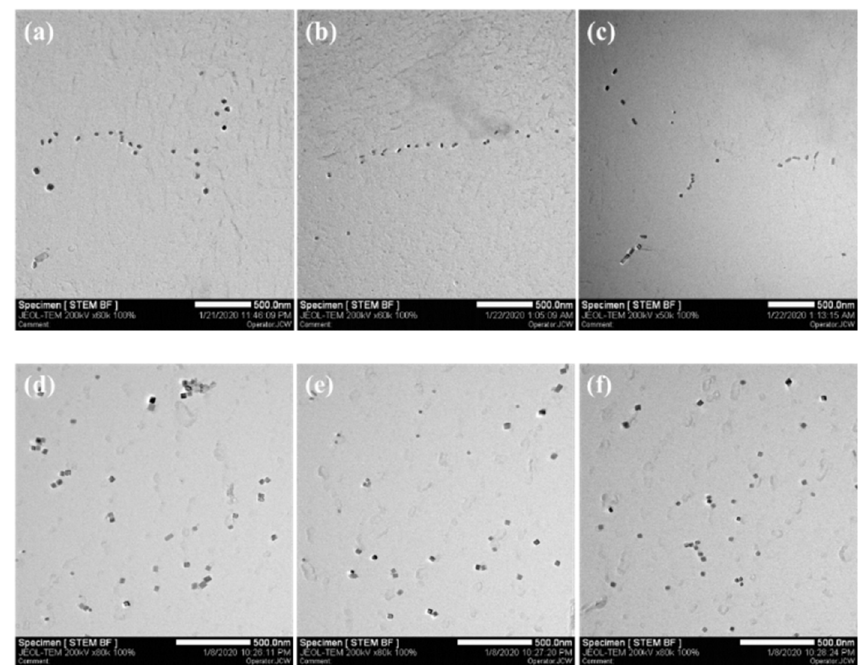
Figure 14. Appearance of nano TiN particles in Ti-bearing peritectic steel specimens: ( a – c ) before magnesium treatment; ( d – f ) after magnesium